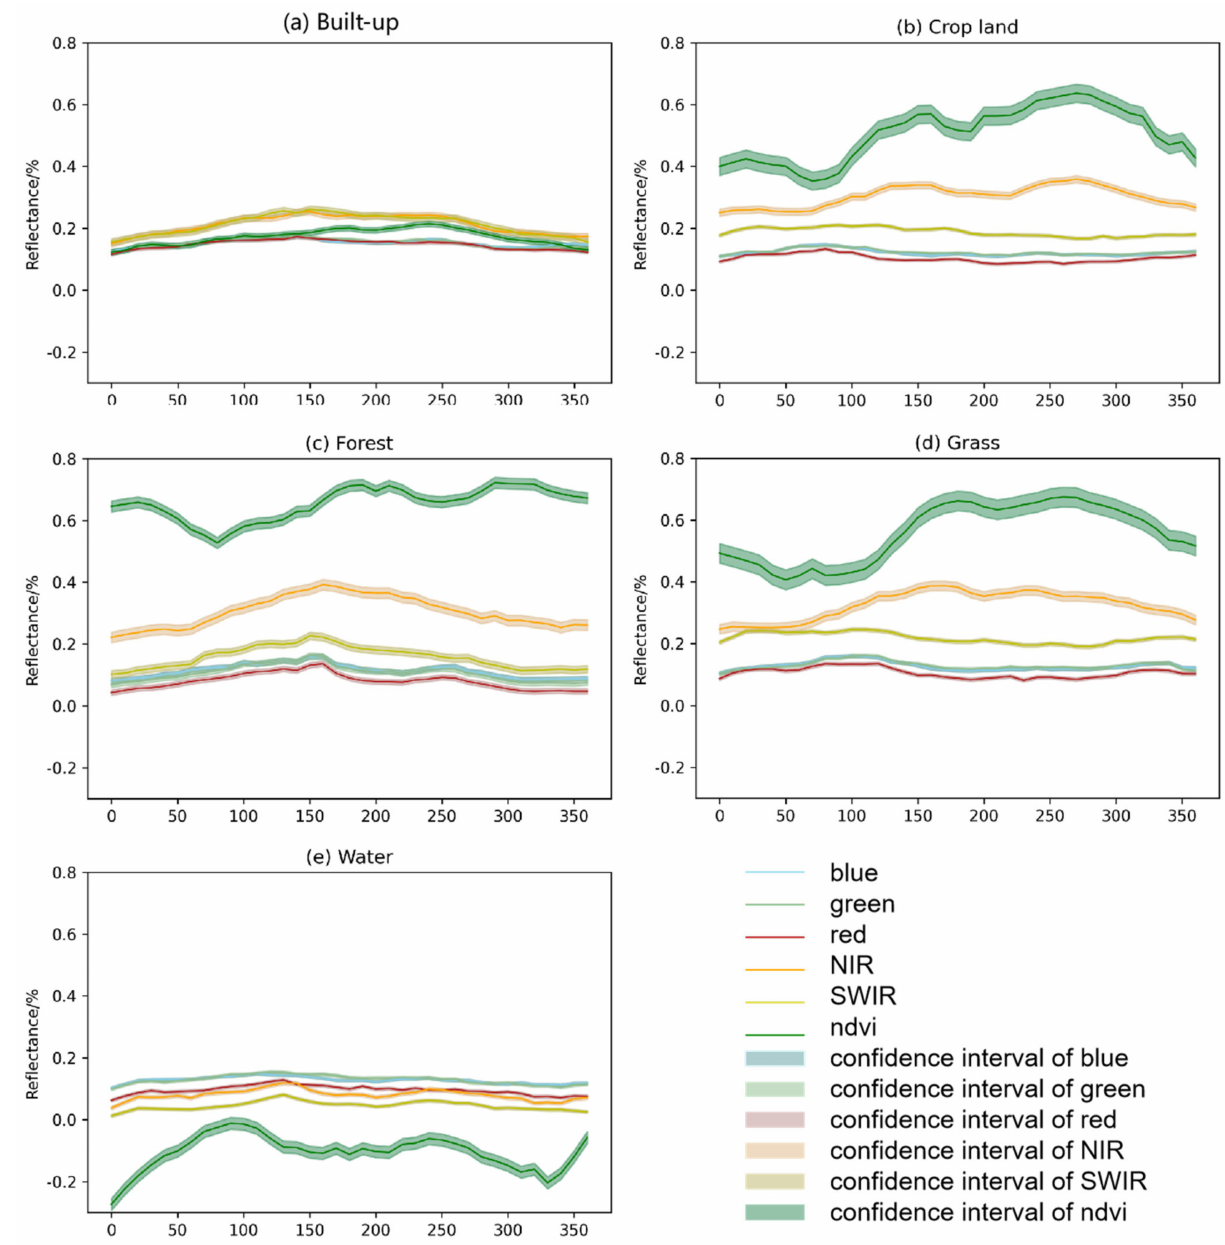
Figure 4. Time − series spectral curves for different land-use types with 1 data every 10 days were synthesized using all available Landsat − 7, 8 and Sentinel-2 remote sensing imagery. The abscissa of the curve is the number of days in a year, and the ordinate is the reflectance of SR. ( a – e ) represent the time − series spectral curves of built-up land, crop land, forest, grass and water,